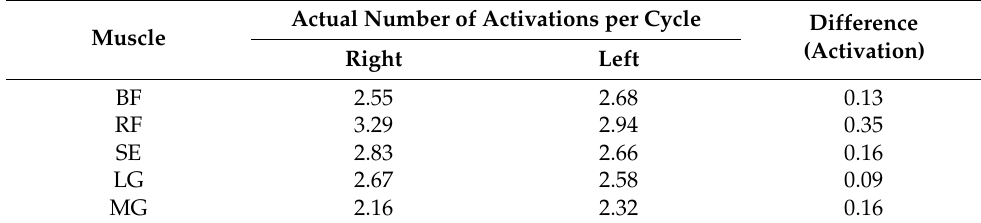
Table 2. Number of activation bursts per cycle. Actual Number of Activations per Cycle Muscle